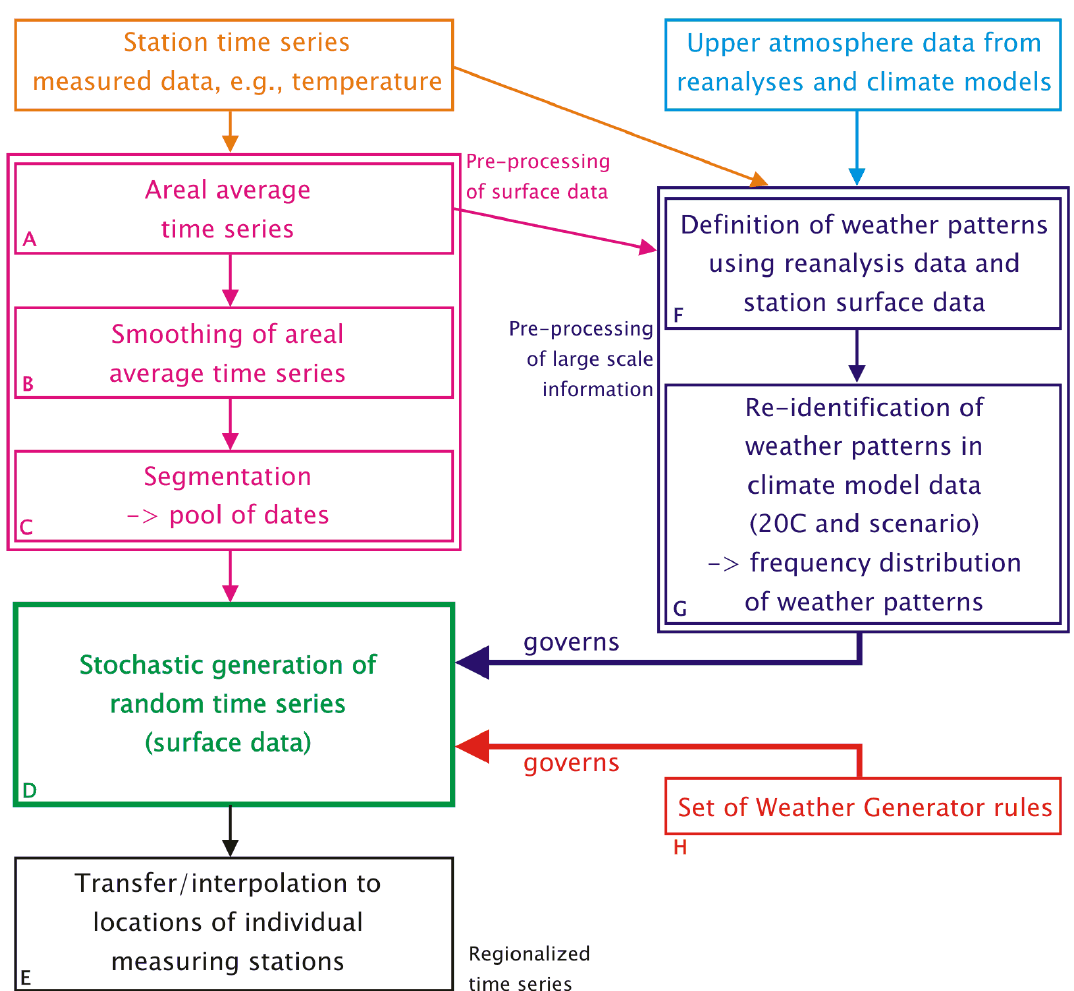
Figure 1. Flowchart of the WETTREG weather generator (WG). The various aspects are described in the sections of this